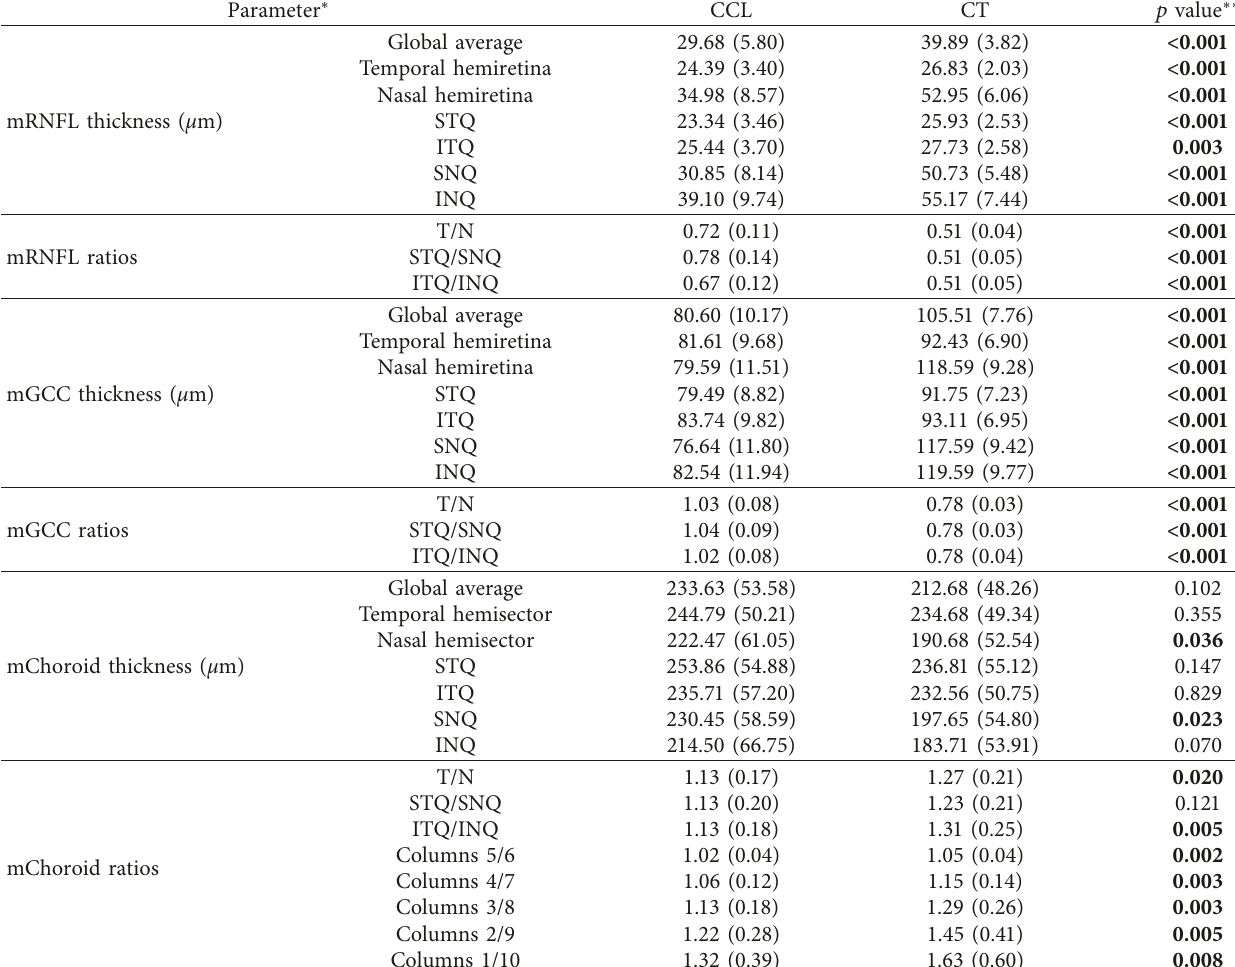
Table 3: Mean values ( ± standard deviation) of inner macular and choroid thickness parameters in eyes with temporal hemianopia from chiasmal compressive lesions (CCL) and healthy controls